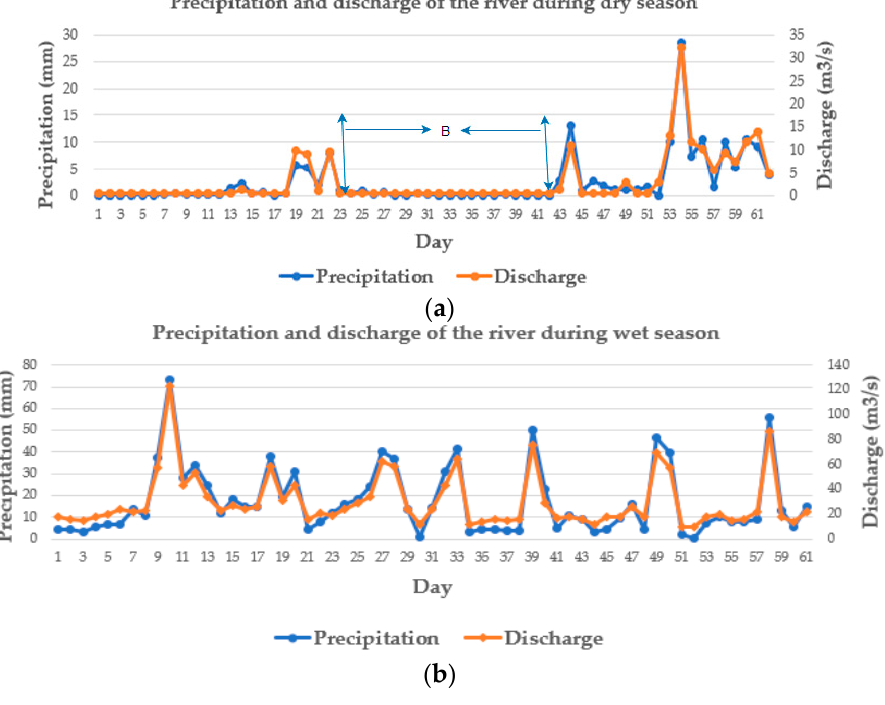
Figure 7. Precipitation and discharge ( a ) in dry season months and ( b ) in wet season months. Our result indicates that the maximum velocity obtained is 5.12 m/s, while the mini- mum and mean velocities are 0.017 m/s and 0.71 m/s, respectively. Figure 8a,b indicates the daily profile of the flow velocity in both dry (18th February to 31st March) and wet months. It is shown in Figure 8a that the velocity varies between 0.024 and 1.34 m/s. Region C and D are constant velocity periods in which the flow emanates only from the base flow discharge. In region C (22nd–25th February), there is minimal rainfall, and the daily precipitation is less than 1.9 mm. However, the base flow is 0.59 m 3 /s, resulting in a flow velocity of 0.024 m/s. Similarly, in region D (13th–18th March), the base flow has a constant value of 2.95 m 3 /s, resulting in a flow velocity of 0.12